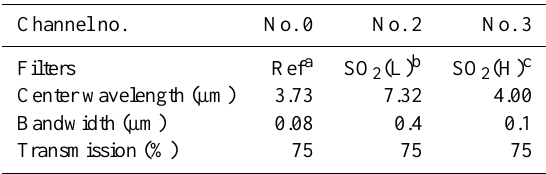
Table 1. Filter parameters: center wavelengths, bandwidths, and transmissions. The bandwidths of Ref, SO 2 (L), and SO 2 (H) filters are calculated using the iterative scheme described in the text. The transmissions of all filters are approximated by Gaussian functions with maximum transmission of 75%.